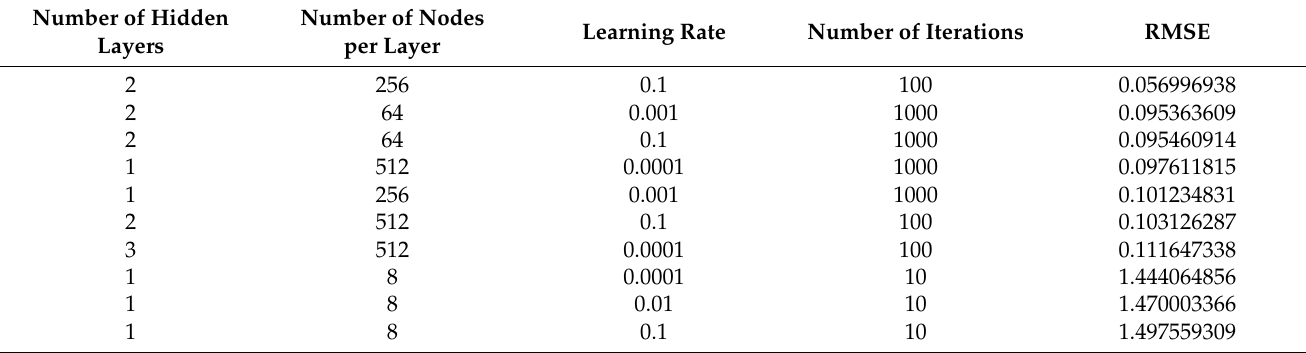
Table 2. Root mean square error of the deep learning network.